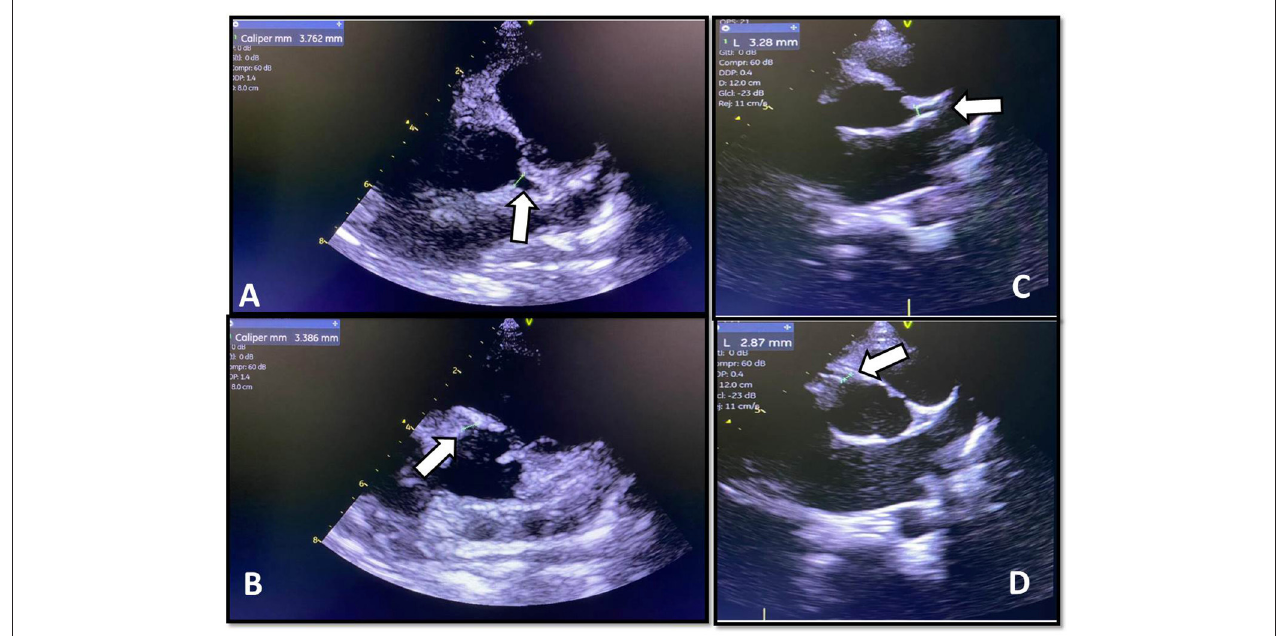
FIGURE 2 | (A) Pretreatment echocardiographic images of the left main coronary artery measuring 3.762mm ( Z score + 3.22). (B) Pretreatment echocardiographic images of the proximal right coronary measuring 3.38mm ( Z score + 2.86). (C) Posttreatment echocardiographic images of the left main coronary artery measuring 3.28mm ( Z score + 2.04). (D) Posttreatment echocardiographic images of the right proximal coronary artery measuring 2.87mm ( Z score +